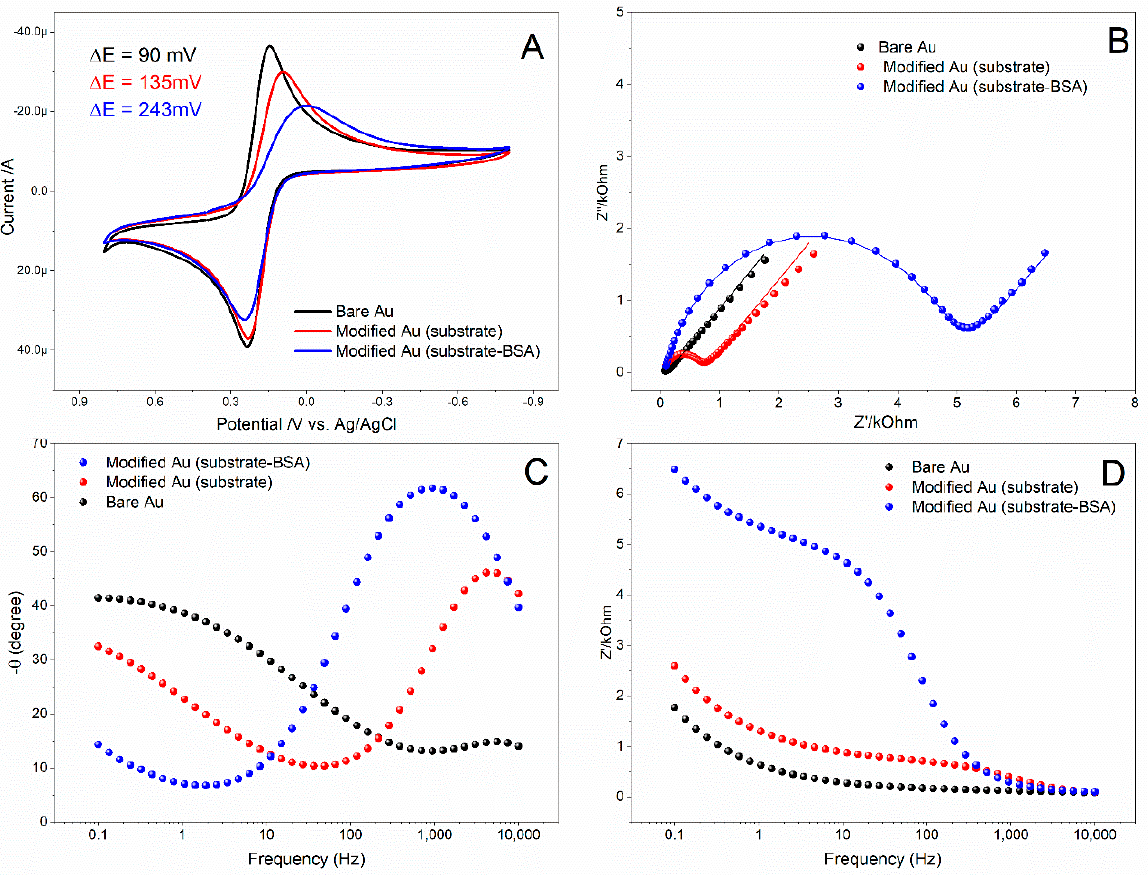
Figure 3. Cyclic voltammograms ( A ), Nyquist ( B ) and Bode plots ( C , D ) of unmodified and modified gold electrodes (substrate, substrate + BSA) in an aqueous solution of [Fe(CN 6 ] 3 − /4 − (5 mM), in phosphate buffer (pH 7.11); scan rate 100 mV·s − 1 .